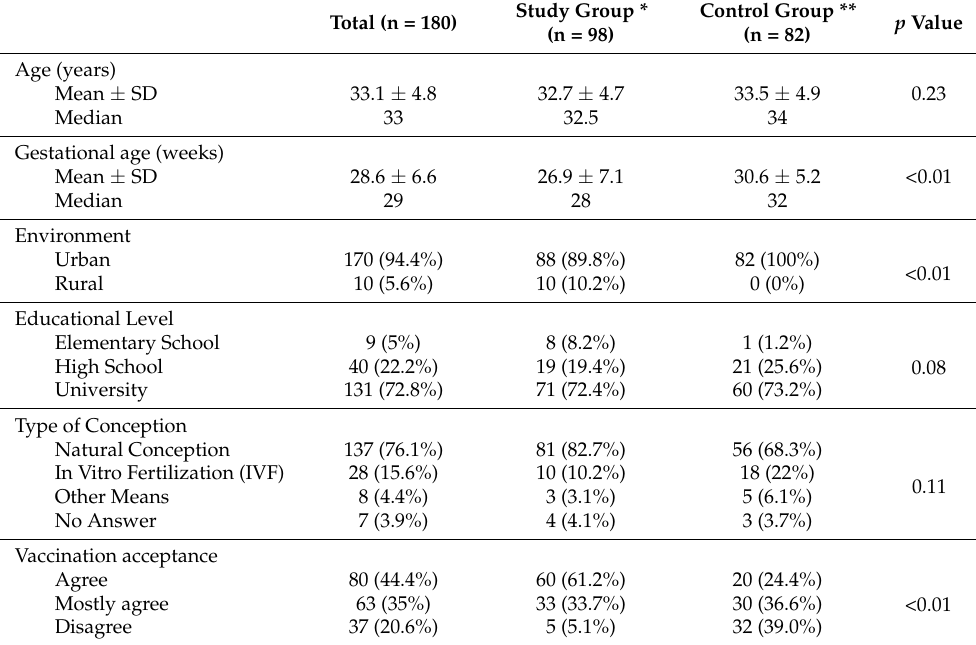
Table 1. Socio-demographic data (180 enrolled pregnant